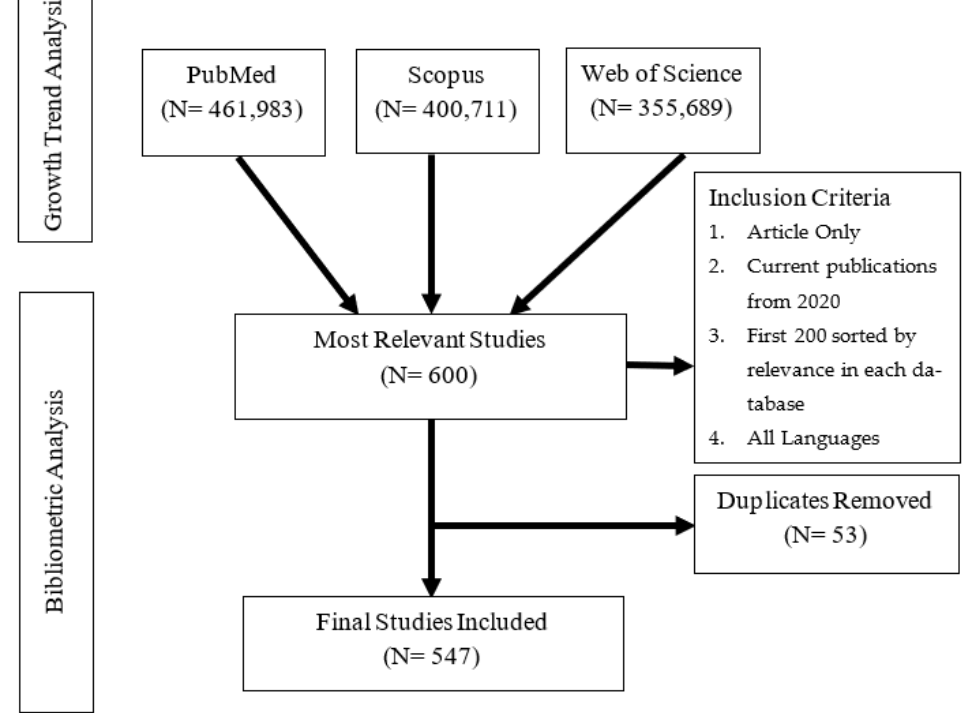
Figure 1. Search process for the selected studies on EoLC.